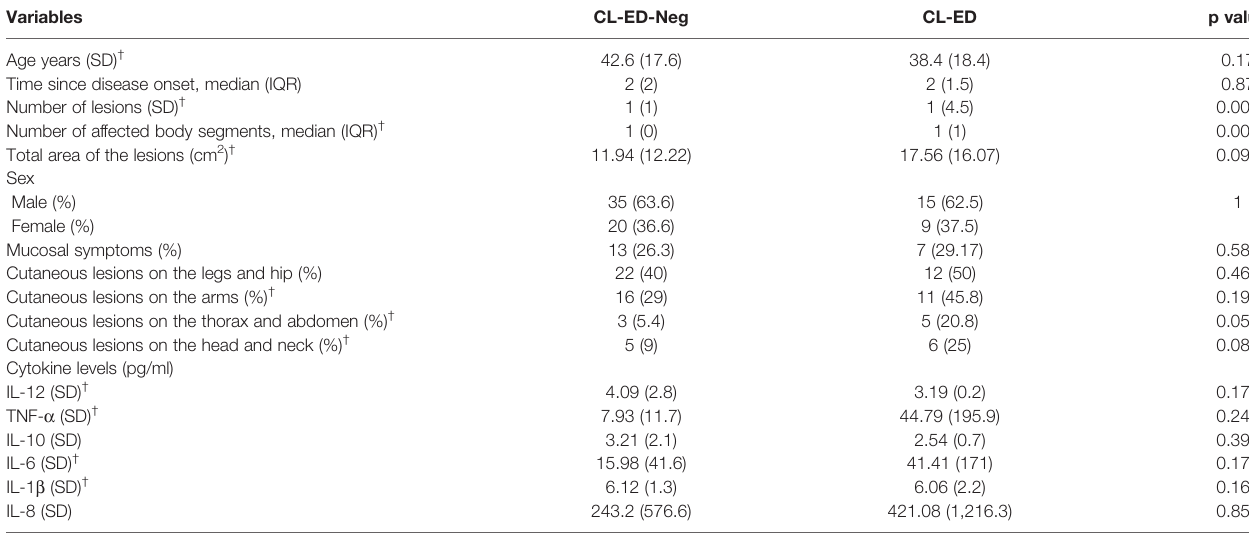
TABLE 2 | Univariate analysis of possible risk factors for early dissemination of Leishmania braziliensis to the nasal mucosa. Variables